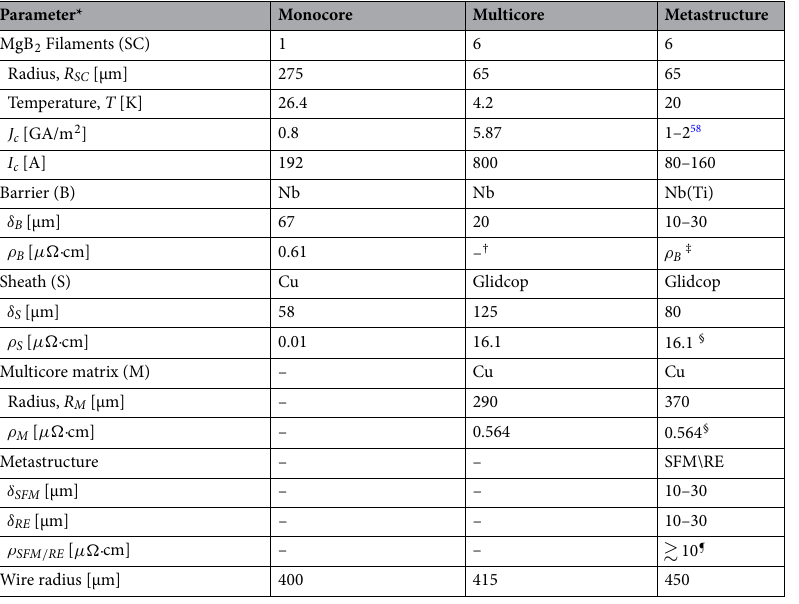
Table 1. Material properties for the MgB 2 wires considered (see insets at Figs. 1, 2). *Material properties of the Monocore and Multicore wires from 59,60 , respectively . δ x and ρ x define the thickness and electrical resistivity of the x − material. † At T = 4.2 K the Nb barrier becomes SC following the same power law for the MgB 2 61 , i.e., E ( J ) = E c ( | J | / J c ) n , with E c = 1 µ V/cm, J c = I c /π( R SC + B thick ) 2 , and n=116. ‡ ρ B ( T = 20 K ) = 0.5 µ� · cm for the Nb barrier 59 and 1.91 µ� · cm for NbTi 58 . § Electrical resistivity of Cu-based metal composites is not expected to change below ∼ 20 K 62,63 . ¶ Calculations have been made for 10–10,000 µ� · cm, with no apparent change on L within a tolerance of 1E−9